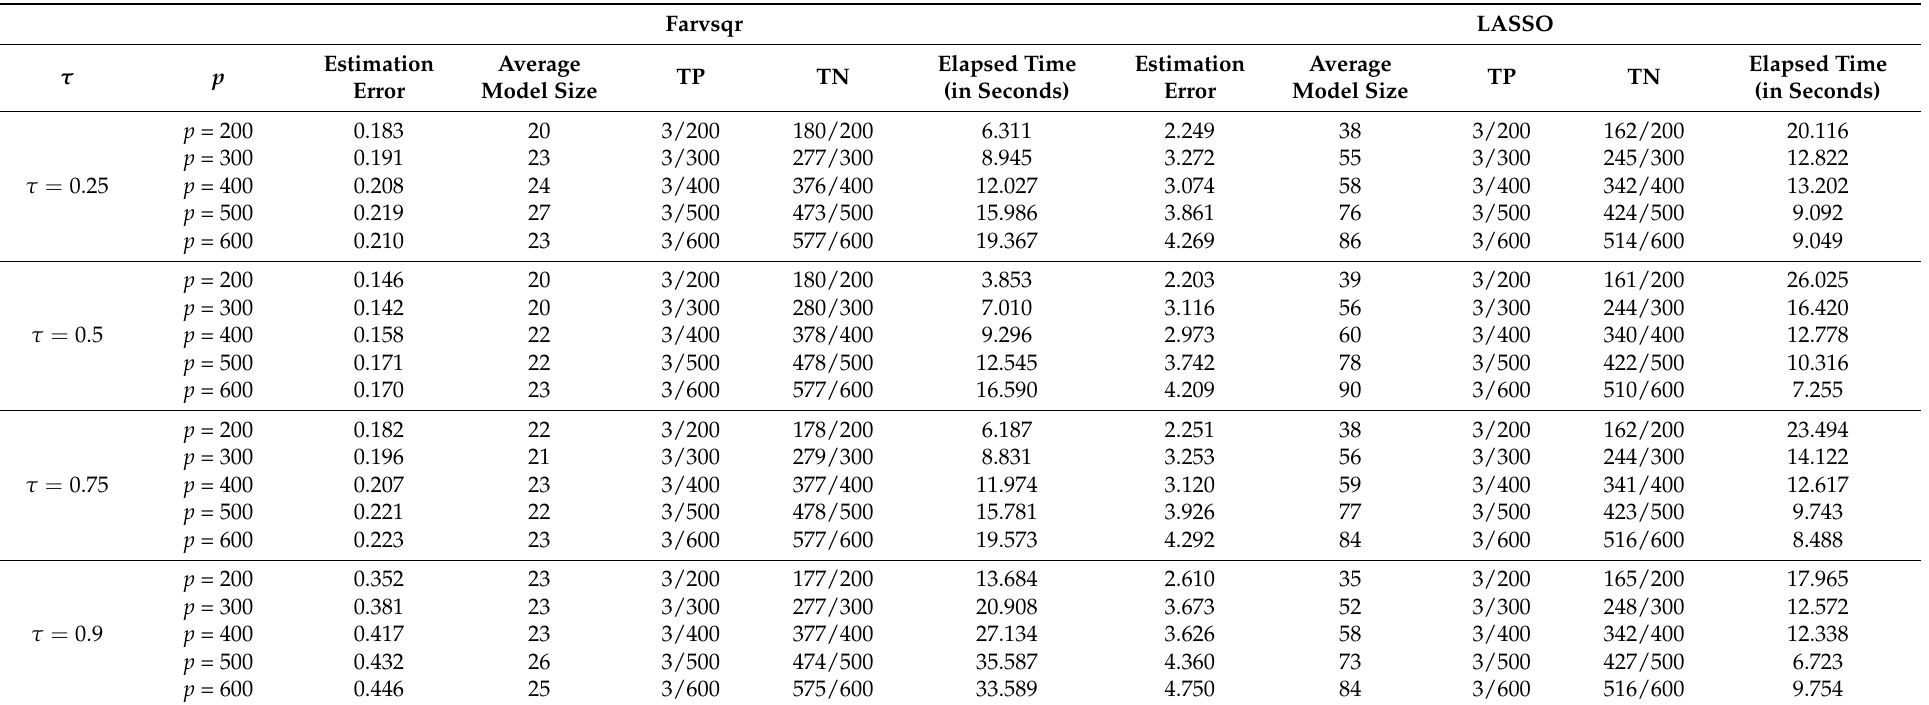
Table 5. The comparison for n = 1000, t 2 with the factor model. Farvsqr